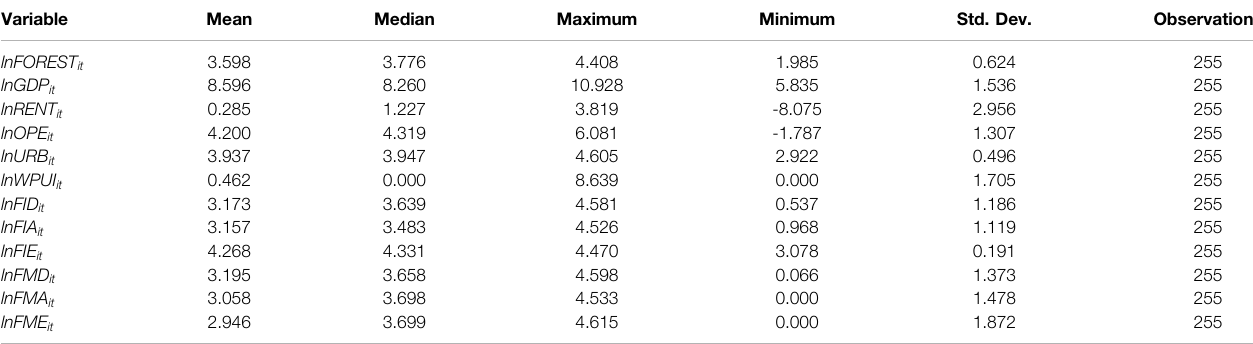
TABLE 2 | A summary of descriptive statistics from 2005 to 2020. Variable Mean Median Maximum Minimum Std. Dev.